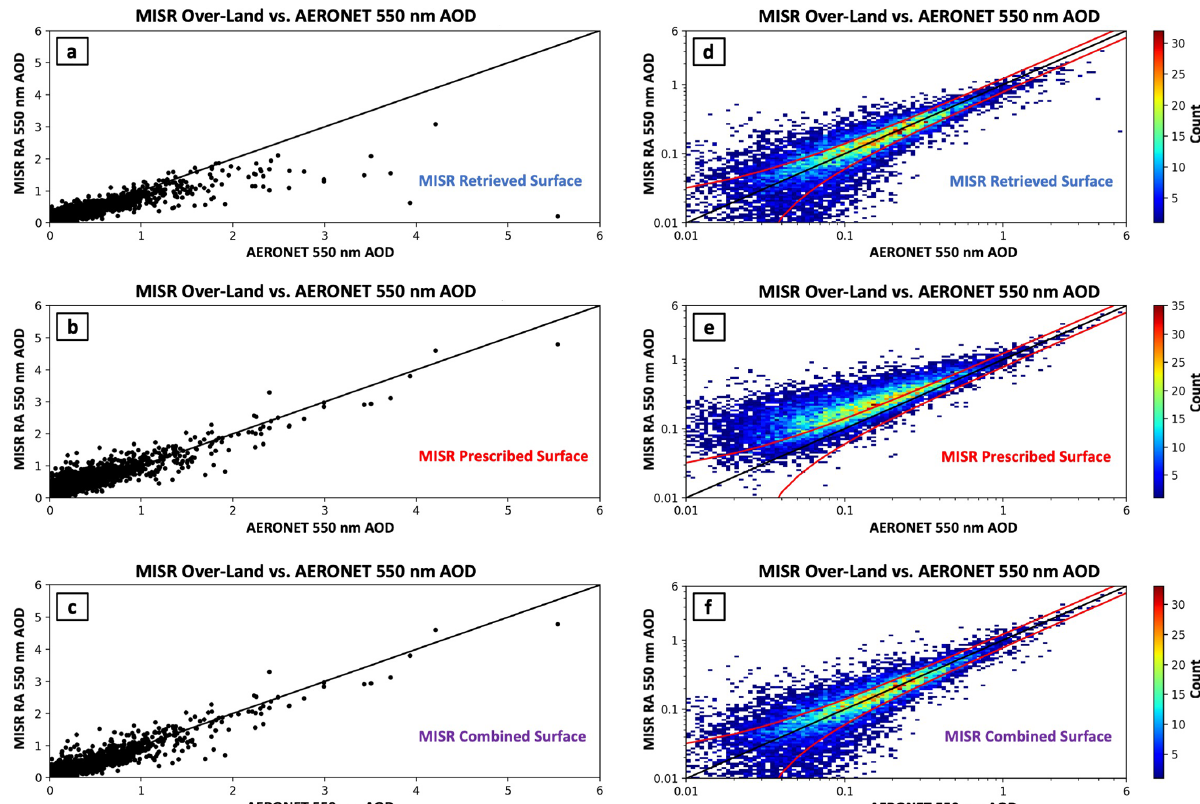
Figure 2. Comparison of MISR RA over-land 550nm AOD retrievals with AERONET direct-sun 550nm AOD. The x axes represent AERONET 550nm AOD and y axes represent MISR RA-retrieved 550nm AOD. The MISR over-land retrieval algorithm type (prescribed surface algorithm – PSA, retrieved surface algorithm – RSA, or combined surface algorithm – CSA) is embedded in the lower right of each panel. Panels (a) and (d) present the MISR RSA, (b) and (e) present the MISR PSA, and (c) and (f) present the CSA. Panels (a)–(c) on the left show scatterplots of MISR RA AOD compared to AERONET, with a linear scale to allow for easier interpretation of high AOD results. Panels (d)–(f) on the right show two-dimensional histograms of MISR RA AOD compared to AERONET, with a logarithmic scale to allow for easier interpretation of low AOD results. Expected error of MISR CSA AOD ± ( 0 . 20 × MISR AOD + 0 . 02 ) is embedded as two red lines in panels (d)–(f)